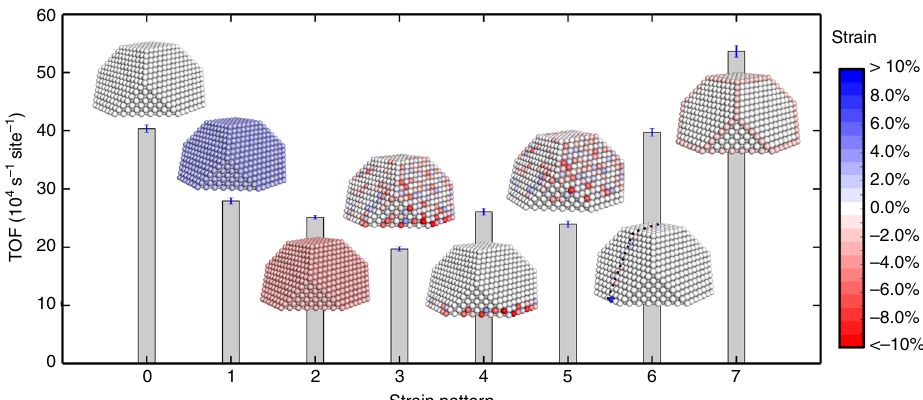
Fig. 4 Predicting the in fl uence of different strain patterns on the catalytic properties of a Pt NP. Turnover frequencies for strain patterns were simulated at 1100 K. Pattern 0: unstrained NP. Pattern 1: 3% expanded. Pattern 2: 3% compressed. Pattern 3: experimental distribution. Pattern 4: experimental strained interface. Pattern 5: experimental strained vacuum surface. Pattern 6: experimental strained twin boundary. Pattern 7: compressed edge and corner sites. The error bars correspond to one standard deviation between 16 identically prepared simulations. Partial pressures: p(CO) = 20 mbar and p(O 2 ) = 10